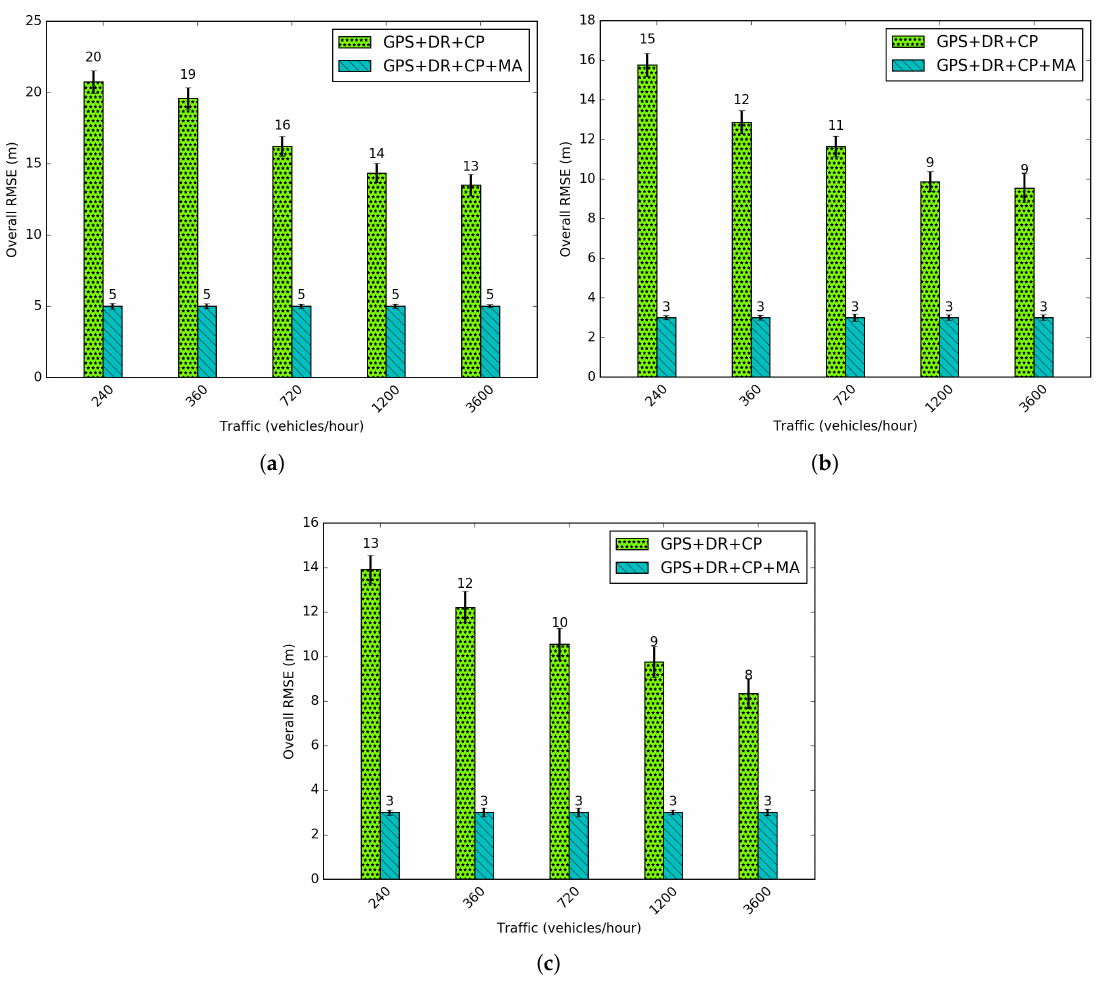
Figure 14. Root mean square errors (RMSEs) for different densities. ( a ) RIO 450 Tunnel (RIO450); ( b ) Robert C. Levy Tunnel (RCLT); ( c ) Douglas McArthur Tunnel